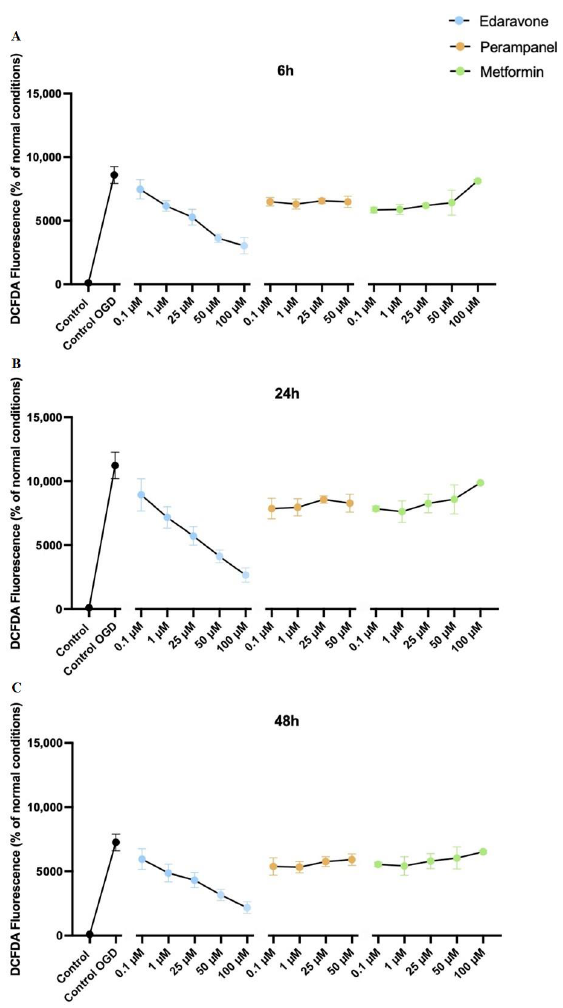
Figure 16. Protective efficacy of edaravone, perampanel, and metformin in HT-22 cells exposed to oxygen–glucose deprivation (OGD) over 6 ( A ), 24 ( B ), and 48 ( C ) hours. DCFDA fluorescence (dye of ROS generation) change percentage (%) of the different concentrations of edaravone, perampanel, and metformin, exposed to OGD. Results are expressed as the percentage of DCFDA fluorescence relative to control cells, in normal conditions. Results were assessed by fluorescence plate reader (SpectraMax Gemini EM Microplate Reader, Molecular Devices, San Jose, California), 485 nm excitation and 530 nm emission. Data are presented as the mean ± SEM of three independent